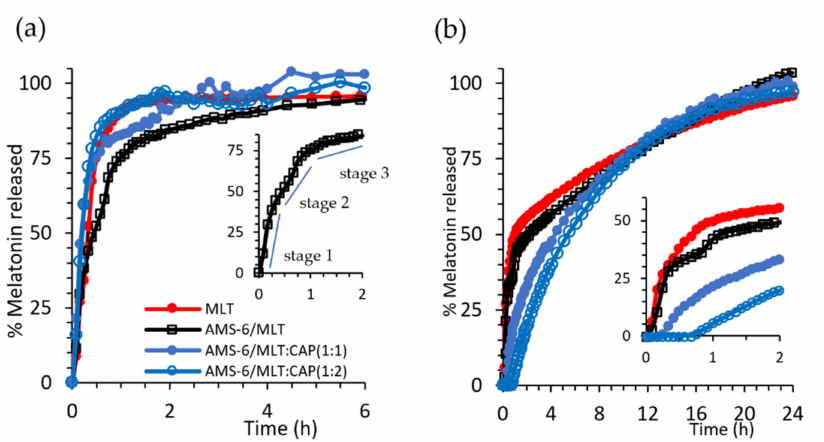
Figure 3. ( a ) Kinetic release measurements of mLT and test formulations in SIF (pH 6.8) and ( b ) SGF (pH 1.2). The inset in ( a , b ) shows the region 0 < t < 2 h for the selected formulations. For ease of comparison, error bars were omitted. The same figure with error bars can be found in the Supple- menatry Material (Figure S2). Every data point represents the average value obtained from a triplicate sample, and the error bars shown in Figure S2 correspond to the calculated standard